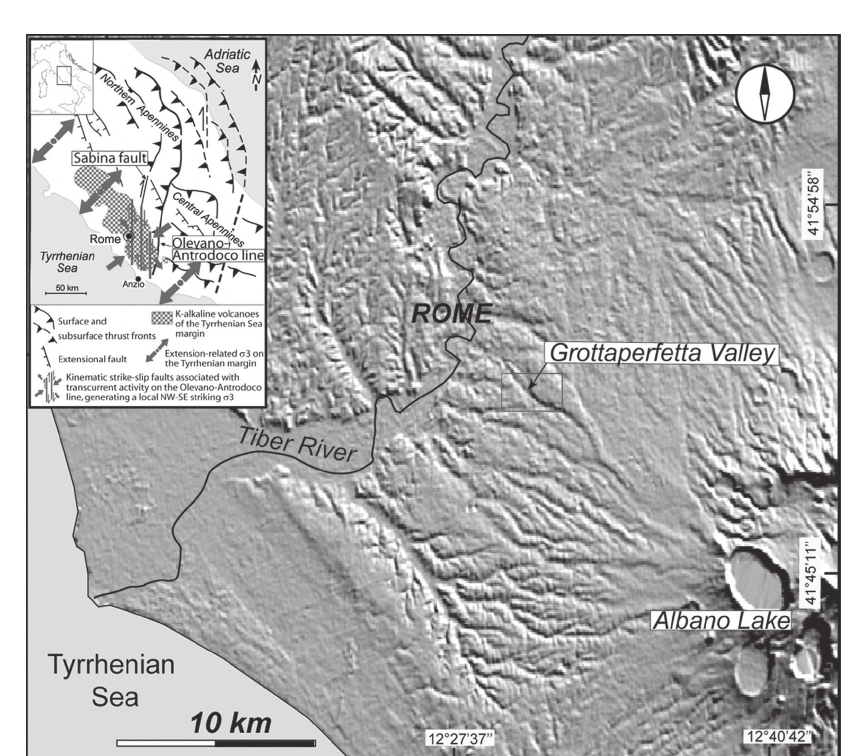
Fig. 1. Shaded relief of the area of Rome showing the morphology related to the hydrographic network of the Tiber River and its tributaries. The studied valley of Grottaperfetta is indicated. The inset shows a schematic structural map of Rome and surrounding region (modified from Marra et al. ,